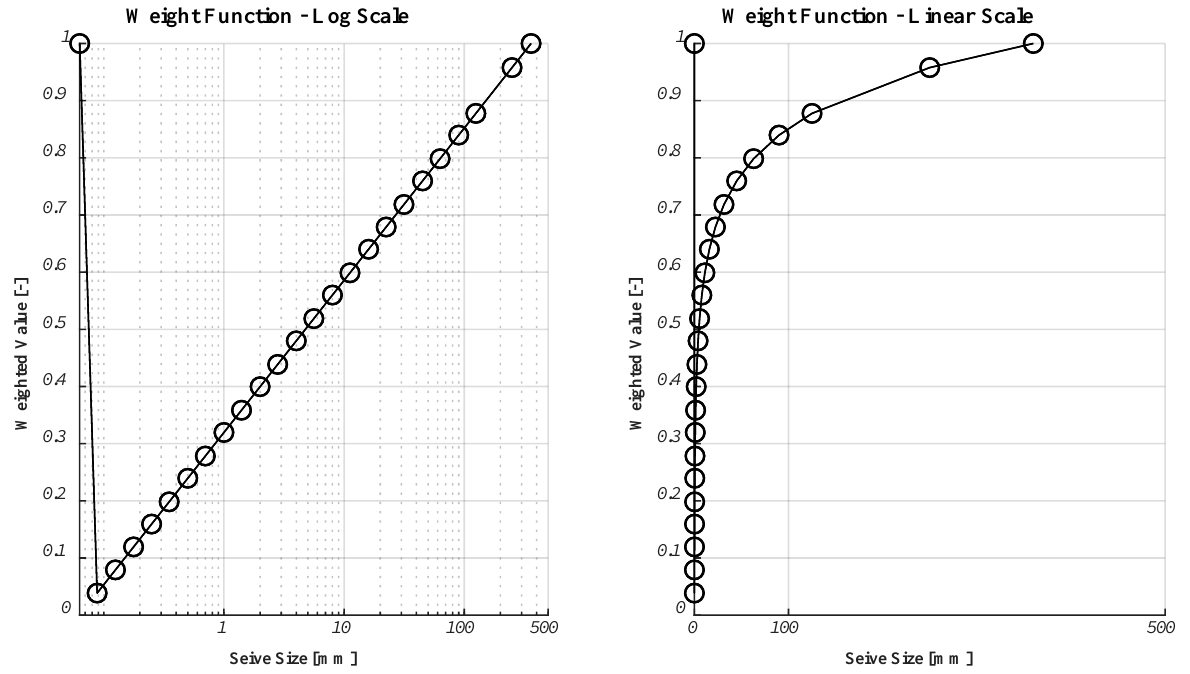
Figure 9. Graphical representation of the weighted function used in the optimization problem for- mulation.